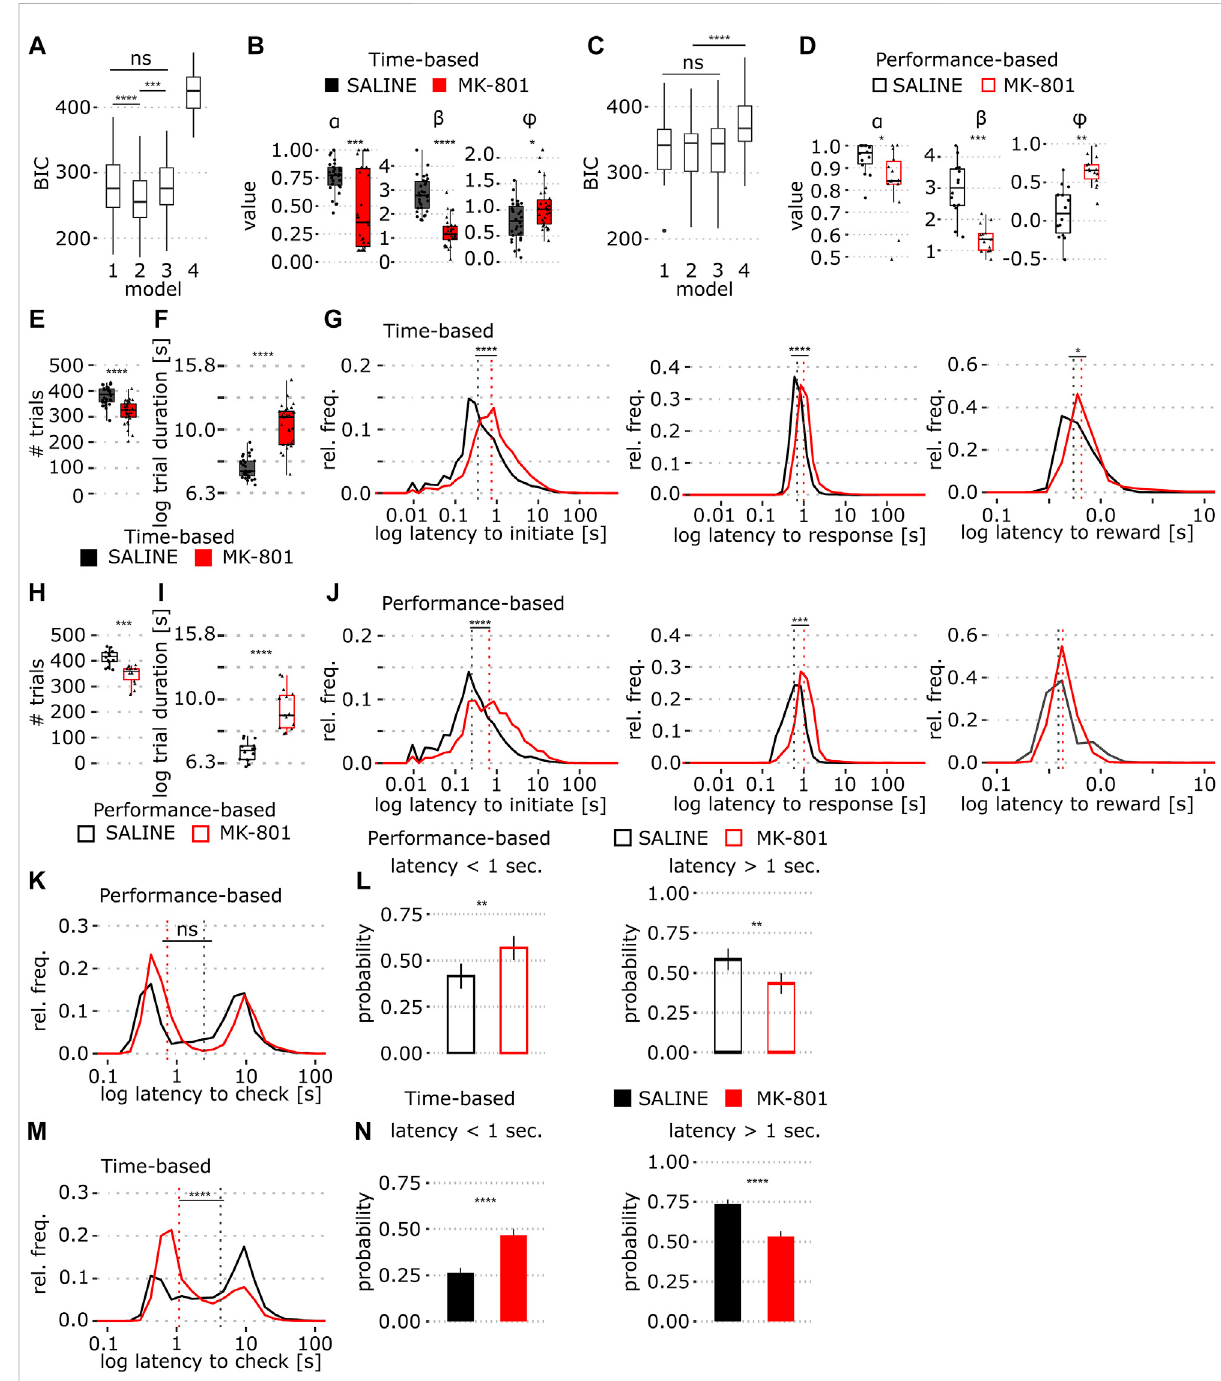
FIGURE 3 Comparison of behavior in time- and performance-based PRL tasks in MK-801. (A) BIC scores of four Rescorla – Wagner (RW) reinforcement learning models fi t to the time-based PRL data; 1: standard RW, 2: RW + stickiness, 3: RW + side bias, and 4: win-stay/lose-shift model. (B) Model 2coef fi cients( α , β ,and φ ) fi ttothetime-based PRLdata. (C,D) Same asA andB,modelswere fi ttoperformance-based taskdata. (E) Numberoftrials inthetime-basedPRL. (F) Time-basedPRLmeantrialdurationacrossalltrials(log10transformed). (G) Time-basedPRLloglatencydistributions of trial initiation (G, left), lever presses (G, middle), and reward collection (G, right). Dashed line indicates median values. (H) Number of trials in the performance-basedPRL. (I) Performance-basedPRLtrialduration(log10transformed). (J) SameasinGbutfortheperformance-basedPRL. (K) Time to magazine entry after unrewarded trials for the performance based PRL. (L) Proportion of short ( < 1 s, L, left) and long latency ( > 1 s, L, right) magazine entries on non-rewarded trials in the performance-based PRL (mean ± SEM). (M,N) Same as in K and L but for the time-based PRL task. Solidandemptyboxplotsshowtime-andperformance-basedtaskdata,respectively.* p < 0.05,** p < 0.001,**** p < 0.0001(seeTable1forstatistical